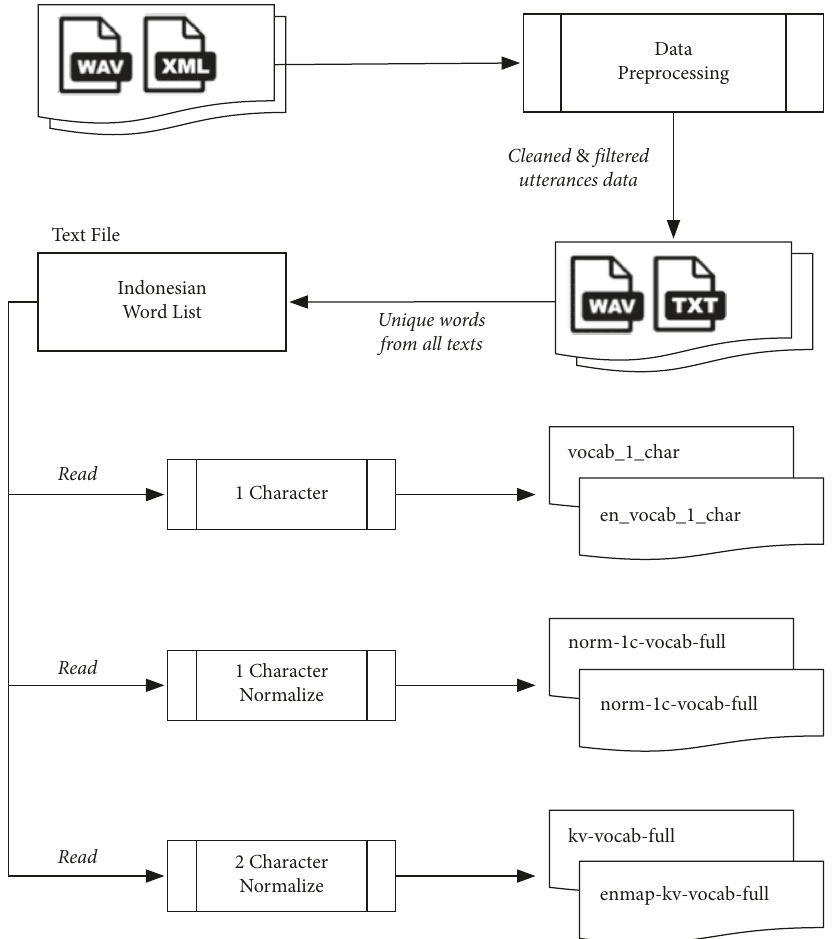
Figure 4: The extraction process of the lexicon from a dictionary.